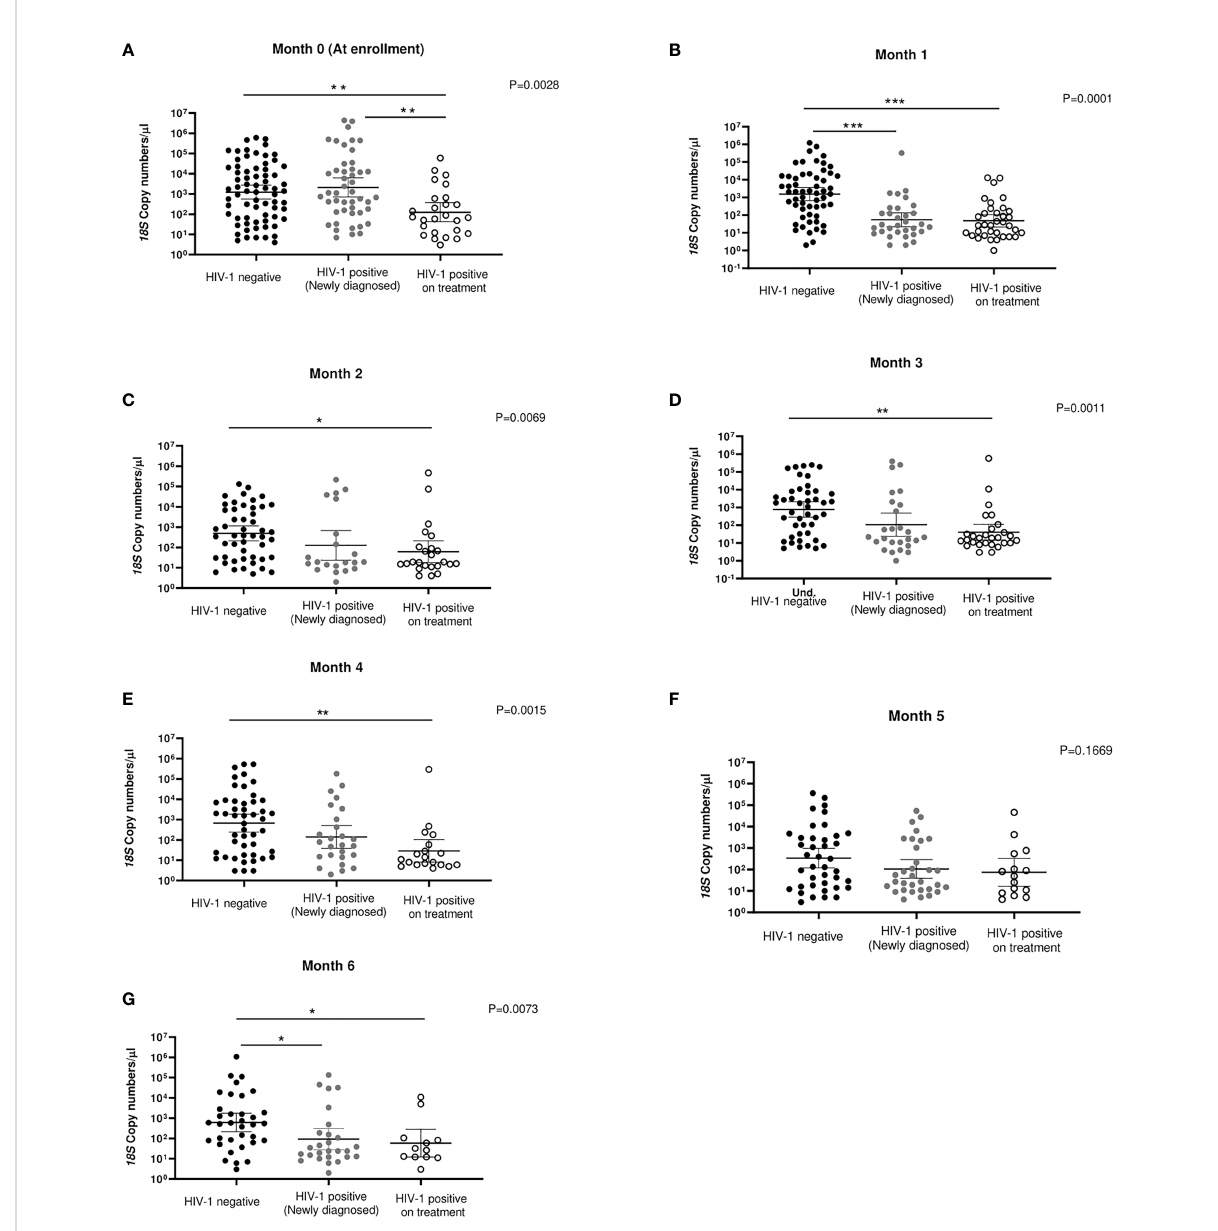
FIGURE 4 18S copy numbers/ m l at enrollment (month 0) (Panel A ) and at follow-up from months 1-6 (Panels B-G ) in the three study groups. p- values at each time-point were determined using Kruskal Wallis test for multiple comparisons followed by Dunn ’ s Test for multiple